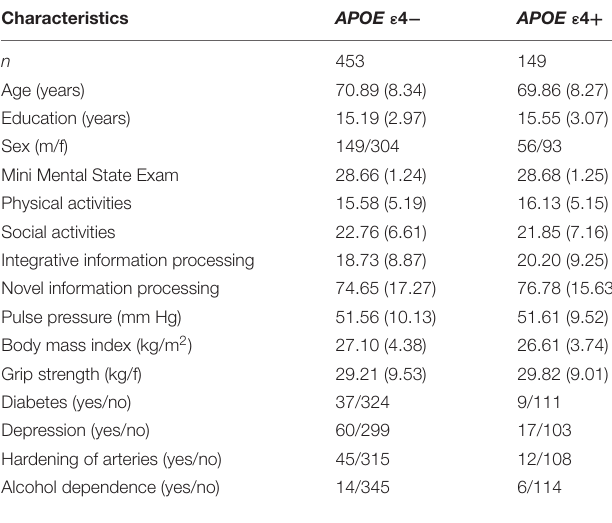
TABLE 1 | Baseline participant characteristics as stratified by Apolipoprotein E ( APOE ) genotype ( ε 4-/ ε 4 + ).